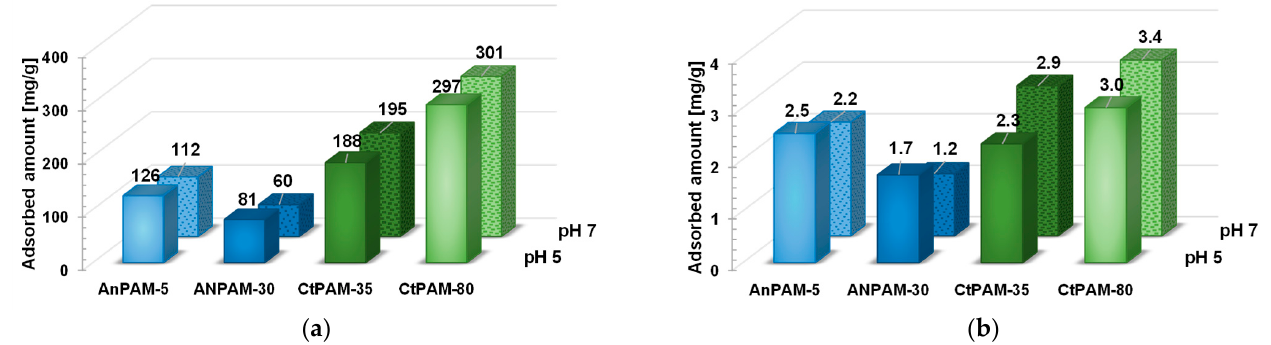
Figure 5. The adsorbed amounts of ionic polyacrylamides on the surface of: ( a ) montmorillonite; ( b ) kaolinite at pH 5 and 7, initial concentration of adsorbates is 100 mg/L. ( b ) kaolinite at pH 5 and 7, initial concentration of adsorbates is 100